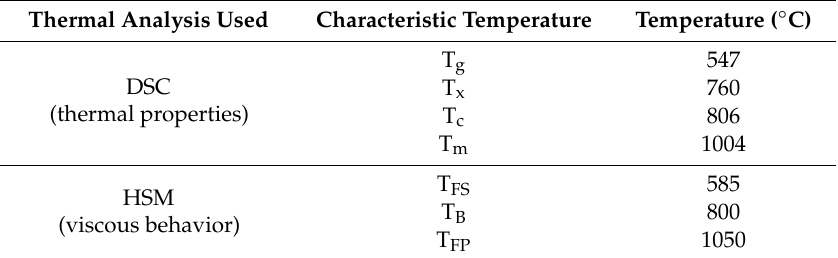
Table 1. Glass transition (T g ), crystallization onset (T x ), crystallization peak (T c ), and melting (T m ) temperatures were obtained from DSC data, while first shrinkage (T FS ), ball (T B ), and flow point (T FP ) temperatures were determined by means of HSM. Table 1. Characteristic temperatures of 47.5B